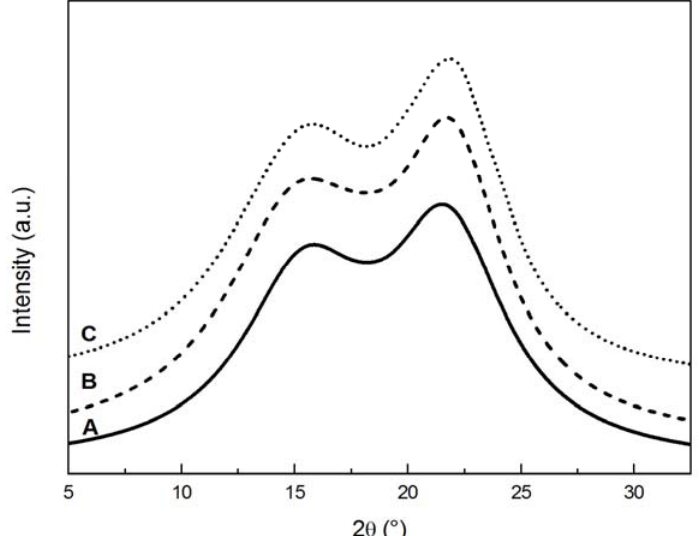
Figure 2. XRD diffractograms of coated wood samples. ( A ) control; ( B ) sample exposed to natural weathering; ( C ) sample artificially weathered